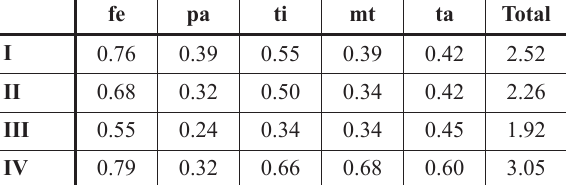
Figs 3H-J, 4E-F, 12L, 14; Appendix